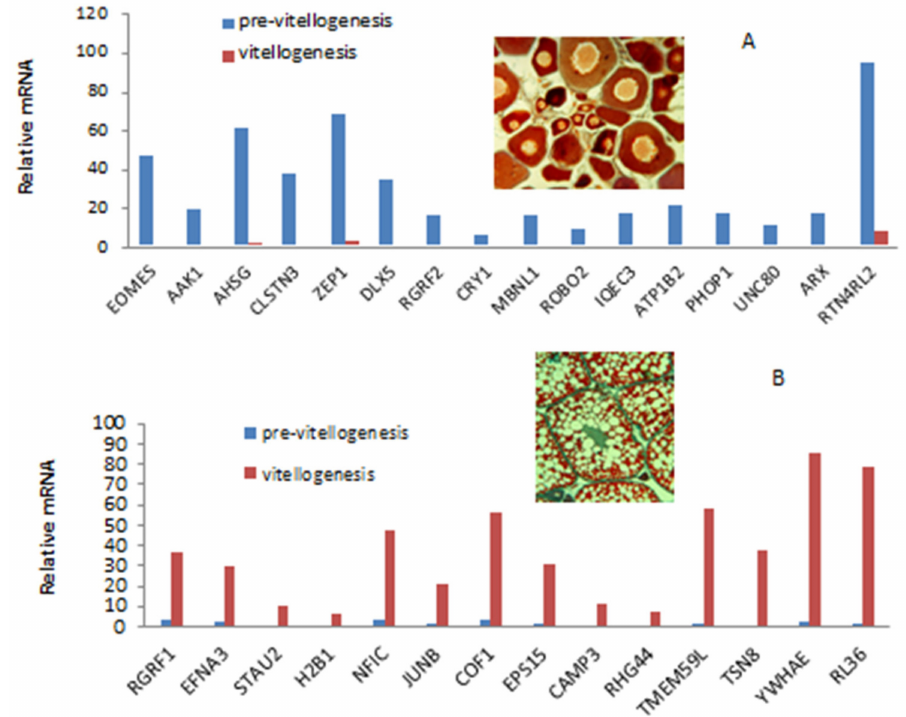
Figure 3. mRNA levels (based on RNA-Seq) of transcripts associated with known genes (Table 1) representing the di ff erences in edgeR analysis ( p < 0.001) between pre-vitellogenesis ( A ) and vitellogenesis ( B ) in female blue gourami brains